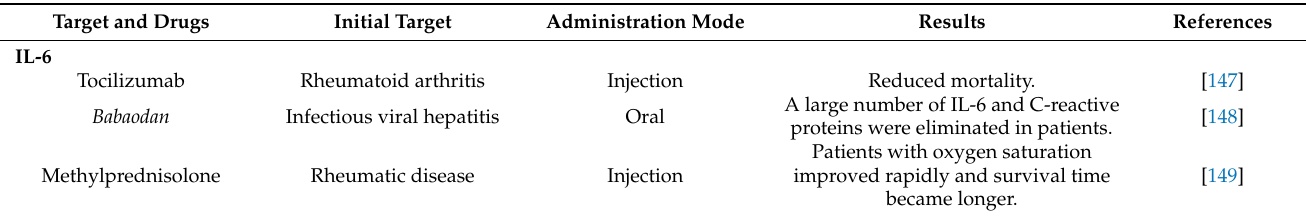
Table 1. Immunosuppressive agents are used to treat COVID-19 inflammatory